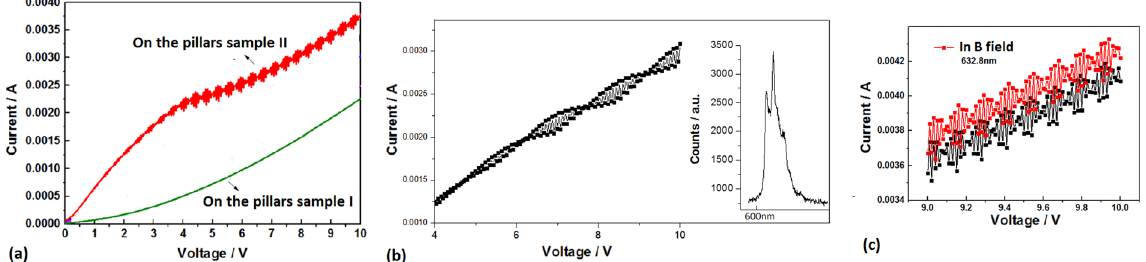
Figure 9. ( a ) The I-V curves in light field of laser at 405 nm on the pillars sample II prepared in oxygen (red curve) and on the Si wafer (green curve), in which the quantum vibration and the quantum platform in the I-V curve occur on the pillars structure doped with oxygen; ( b ) The detail of quantum vibration on the quantum platform of I-V curve on the pillars sample II, in which the twin peaks in the PL spectrum indicate the twin states in the localized states; ( c ) The change of the quantum vibration in magnetic field with 0.33T (red curve) on the sample